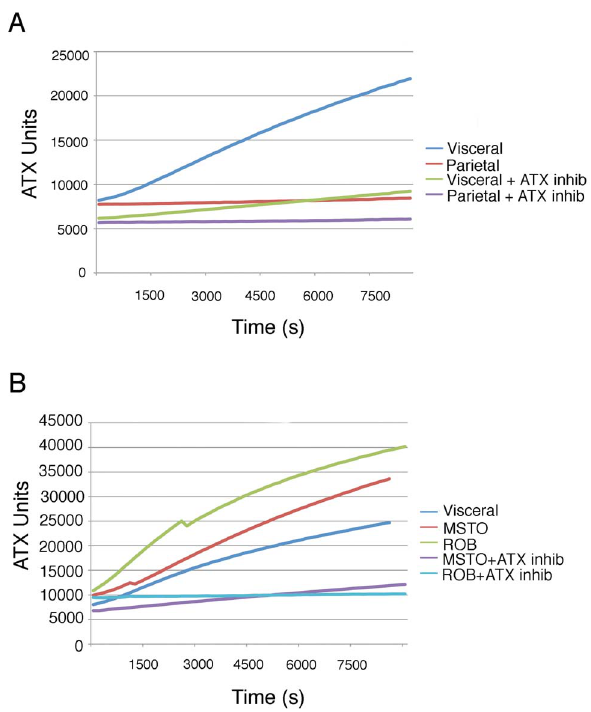
Figure 3. Autotaxin activity is significantly up-regulated in visceral mesothelia and mesotheliomas. Conditioned media was collected from cultured visceral mesothelia, parietal mesothelia, peritoneal mesothelioma (MSTO), and pleural mesothelioma (ROB) cells. Some cultures were treated with the autotaxin inhibitor S32826. Media was assayed for LPA accumulation as a measure of autotaxin activity over a 2 hour period. Visceral mesothelia had significantly higher levels of autotaxin activity compared to parietal cells (A). Furthermore, MSTO and ROB cells had even higher levels of autotaxin activity compared to normal mesothelial cells (B). Normal and pathological cells were responsive to S32826 and displayed decreased levels of autotaxin activity (A–B).